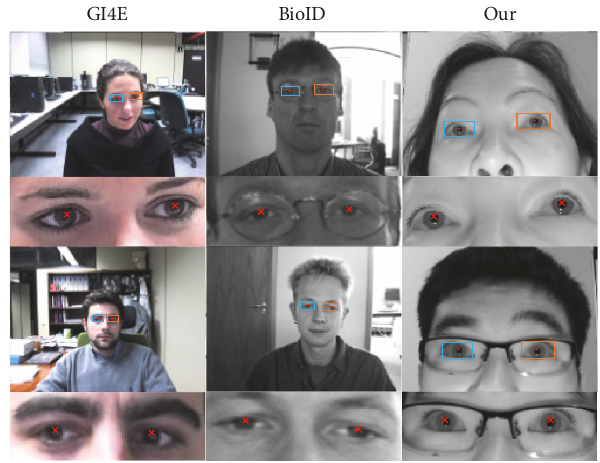
Figure 9: Samples of eye detection, classification, and eye center estimation results on BioID, GI4E, and our datasets. Red cross represents estimated eye center.